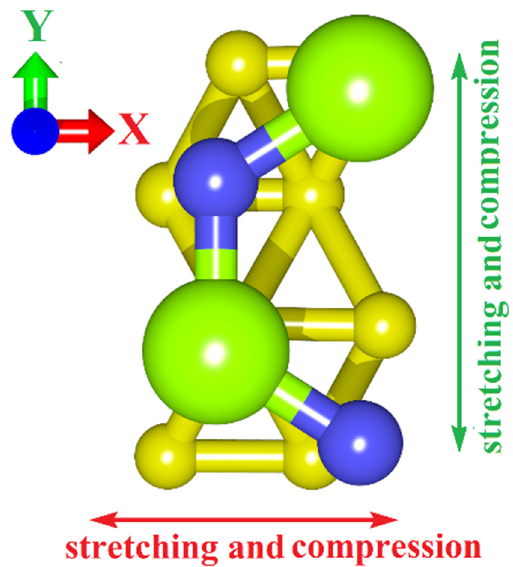
Figure 5. Scheme of stretching/compression of the van der Waals heterostructures under study on the example of a supercell of borophene/ZnO heterostructure.